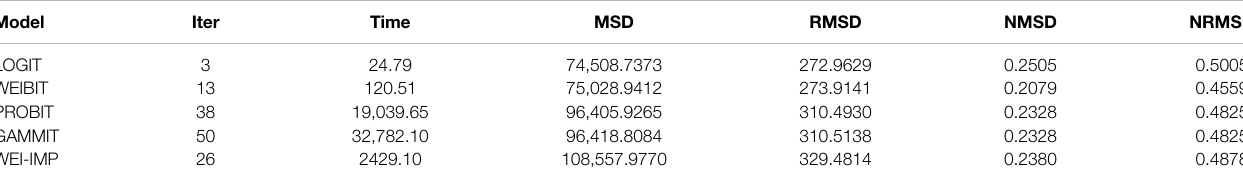
TABLE 8 | Results for MSA-FA experiments on a real network of Salerno.